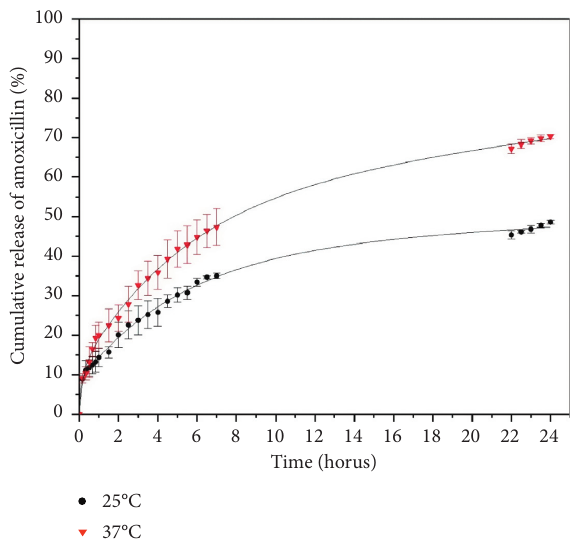
Figure 11: Cumulative release of amoxicillin from composite hydrogels PAAm/starch 50/50 in PCA, pH 3.0 at 25 ° C and 37 ° C. The error bars represent the standard deviation ( n � 3).